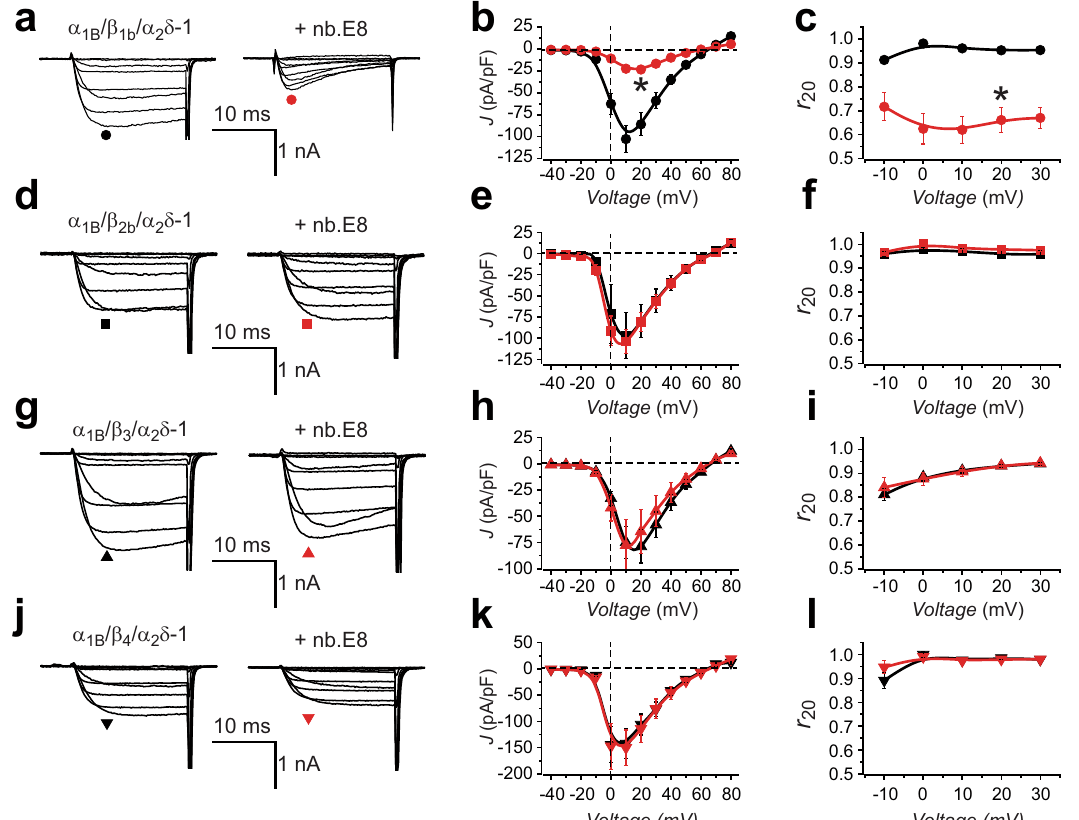
Fig. 4 | Nb.E8 inhibits current amplitude and speeds inactivation in Ca V β 1 - associatedCa V 2.2channels.a ExemplarfamilyofwholecellcurrentsfromHEK293 cells expressing reconstituted Ca V 2.2channels( α 1B + β 1b + α 2 δ -1)in the absence(left) or presence (right) of nb.E8. b Population current density vs voltage (J-V) rela- tionshipforcellsexpressing α 1B + β 1b + α 2 δ -1intheabsence(blackcircles; n =20cells examined over 4 independent experiments) or presence (red circles; n =16 cells examined over 4 independent experiments) of nb.E8. * P =6.5×10 − 5 , two-tailed unpaired t -test. c Fractionalcurrentremainingafter20ms(r 20 )atvarioustestpulse voltagesforcellsexpressing α 1B + β 1b + α 2 δ − 1intheabsence(blackcircles; n =20cells examined over 4 independent experiments) or presence (red circles; n =13 cells examined over 4 independent experiments) of nb.E8. * P =7.4×10 − 5 , two-tailed unpaired t test. d – f Data for α 1B + β 2b + α 2 δ − 1 ± nb.E8, same format as ( a – c ). e n =8 cells examined over 3 independent experiments (black symbols) and n =6 cells